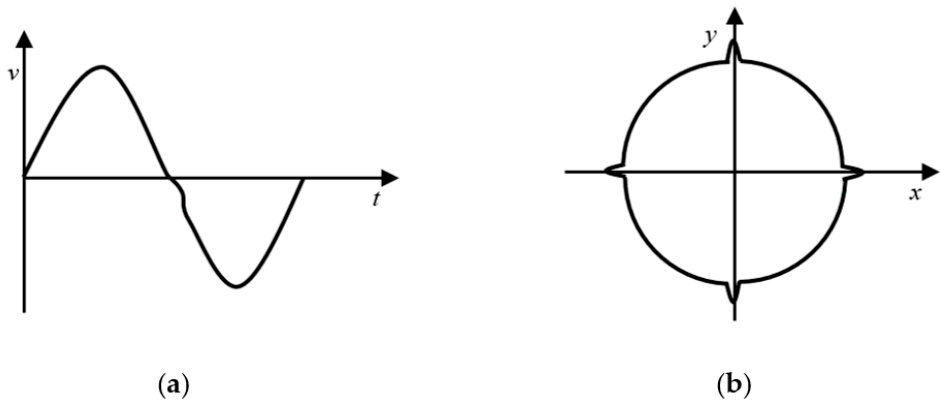
Figure 1. Effect of friction on control performance. ( a ) Speed “zero crossing”; ( b ) over-quadrant sharp corners.